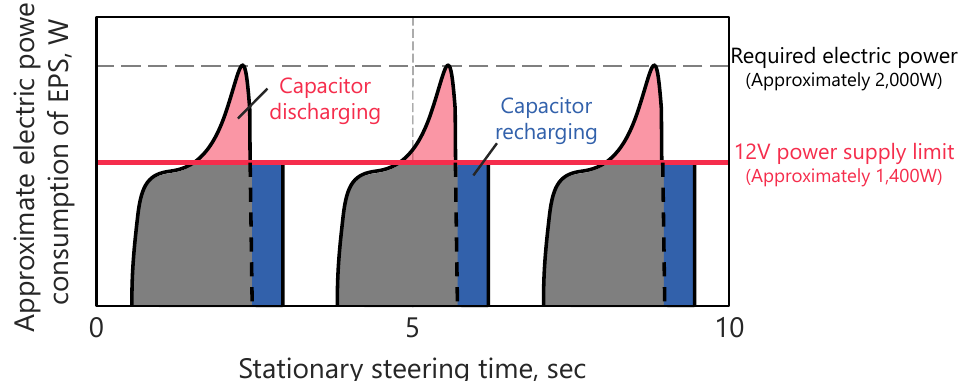
Figure 6. Electric power waveform during continuous stationary steering test of 3.5-ton class full-size vehicle (the steering speed is 600 °/s).